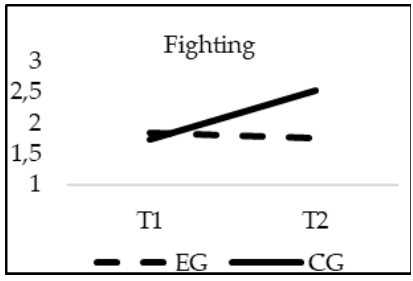
Figure 2. Interaction effects of group (EG-CG) and time (T1-T2) in Peer Victimization.